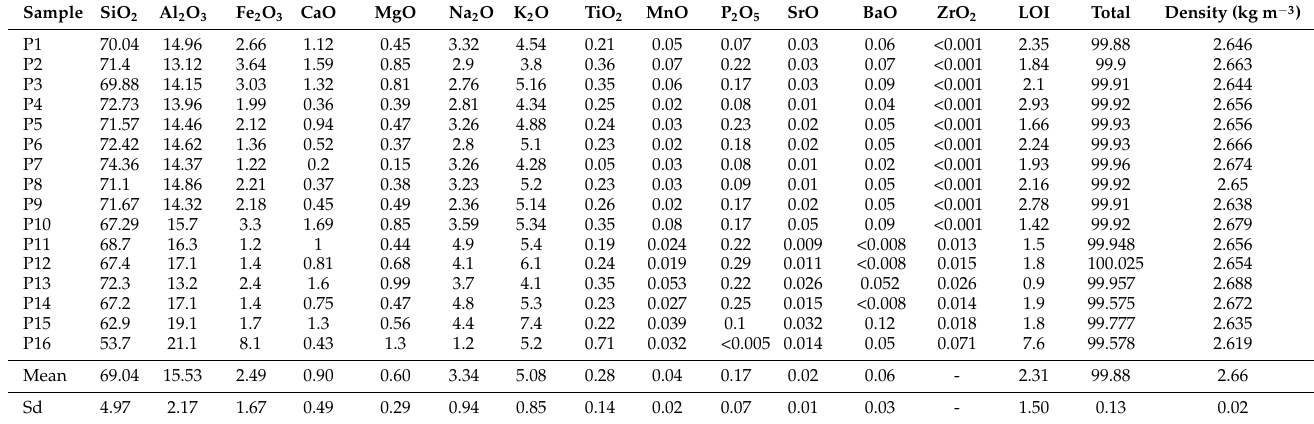
Table 2. Oxides provided by XRF results (in %) and estimated density (in kg m − 3 ).